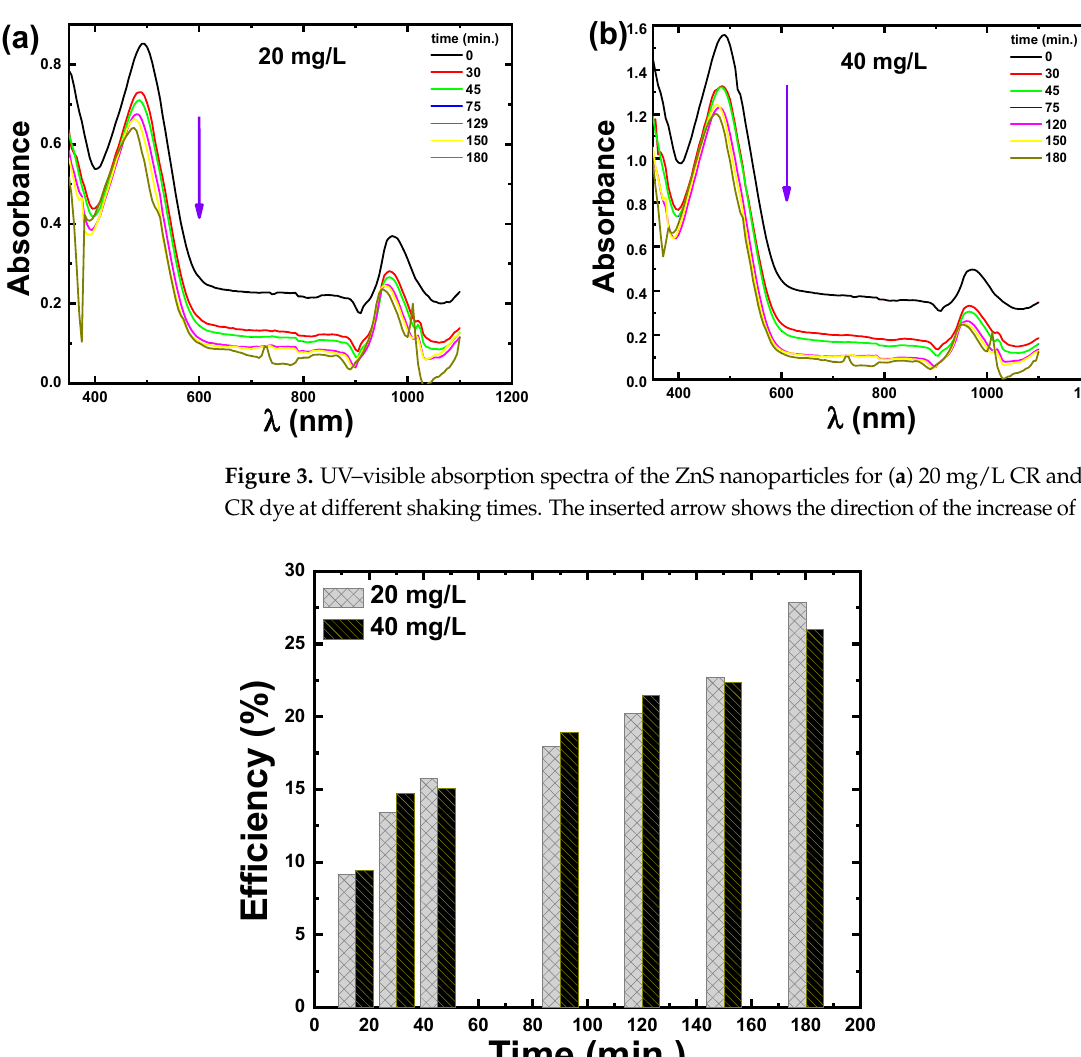
Figure 4. The catalytic efficiency at various shaking times of 20 mg/L and 40 mg/L CR dye using ZnS